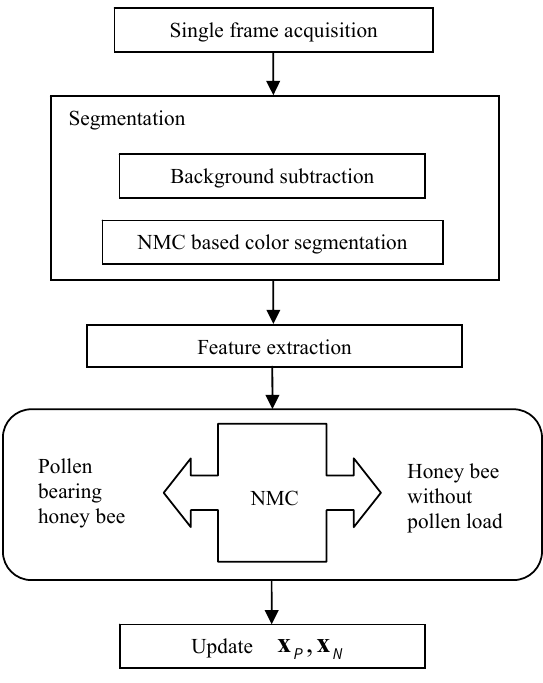
Figure 3. Block diagram of pollen bearing honey bee